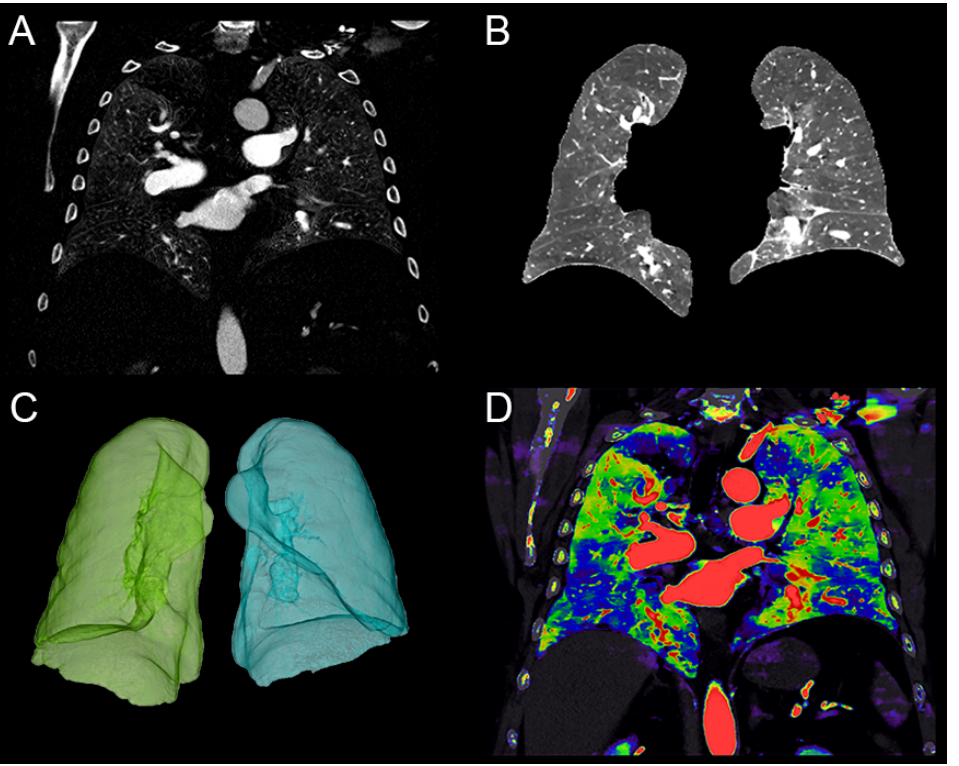
Figure 1. Quantification of the lung perfusion blood volume (PBV) in a 64-year-old male patient with chronic thromboembolic pulmonary hypertension (CTEPH). ( A ) Coronal image of the lung iodine density map. ( B ) Coronal image after lung segmentation with the semi-automatic software COPD (IntelliSpace Portal; Philips Healthcare ® ) allowing the exclusion of the main pulmonary vessels. ( C ) Volumetric segmentation of the lungs. ( D ) Overlay coronal image of the conventional and iodine density maps representing the defect perfusion of the CTEPH condition.